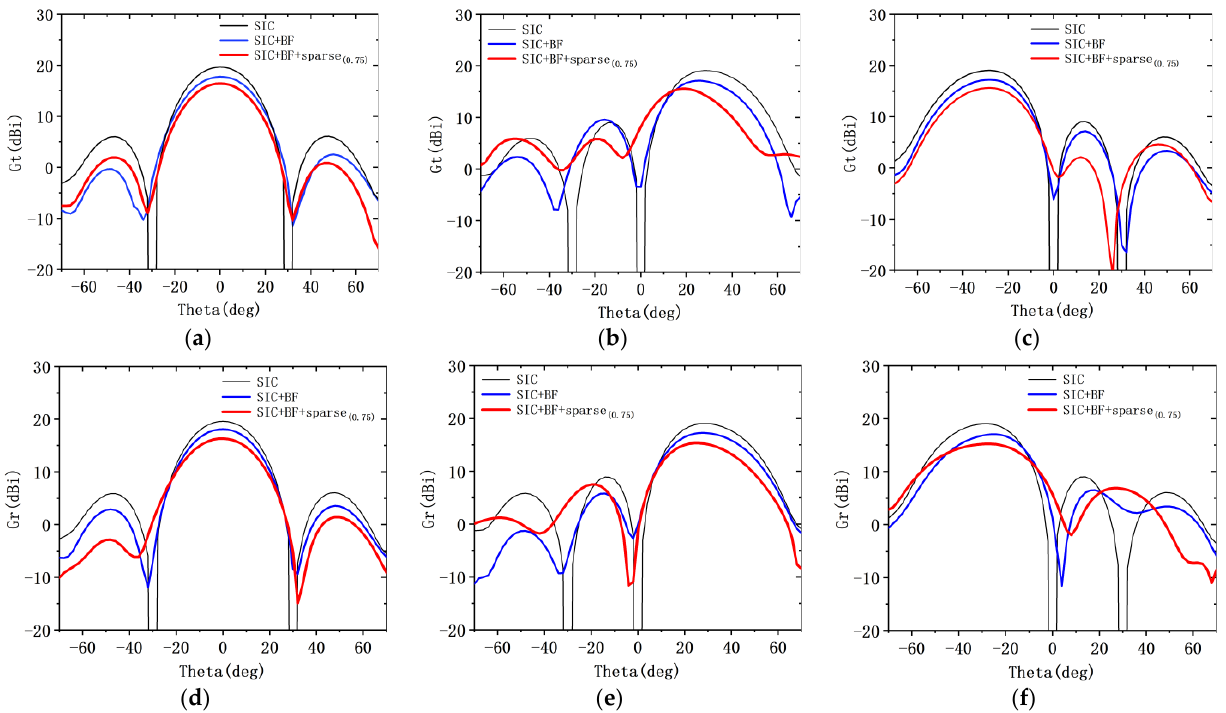
Figure 6. G t and G r curves of SIC, SIC-BF and SIC-BF-sparse arrays with sparsity rate of 0.75 in G curves of SIC, SIC-BF and SIC-BF-sparse arrays with sparsity rate of 0.75 in differ- Figure 6. and r different scan angle at 4.3 GHz: ( a ) Scan angle of 0 ◦ ; ( b ) Scan angle of 30 ◦ ; ( c ) Scan angle of − 30 ◦ ; ent scan angle at 4.3 GHz: ( a ) Scan angle of 0°; ( b ) Scan angle of 30°; ( c ) Scan angle of −3 0°; ( d ) Scan ( d ) Scan angle of 0 ◦ ; ( e ) Scan angle of 30 ◦ ; ( f ) Scan angle of − 30 ◦ angle of 0°; ( e ) Scan angle of 30°; ( f ) Scan angle of −3 0°.